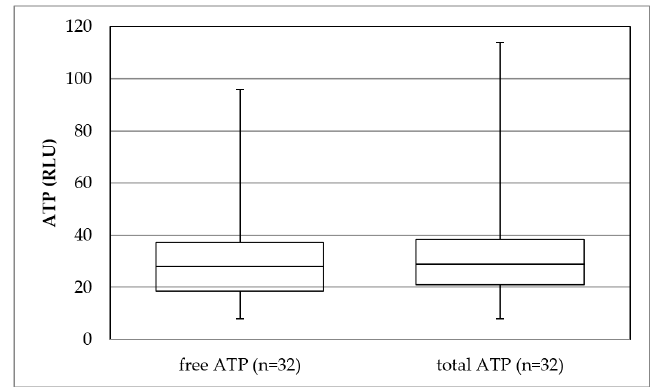
Figure A1. The results of the ATP measurements after ultrafiltration comparing free non-cell bound ATP (left) and total ATP (right). Table A1. The standard deviation of the laboratory results for the UF membrane plant, convergence checked.